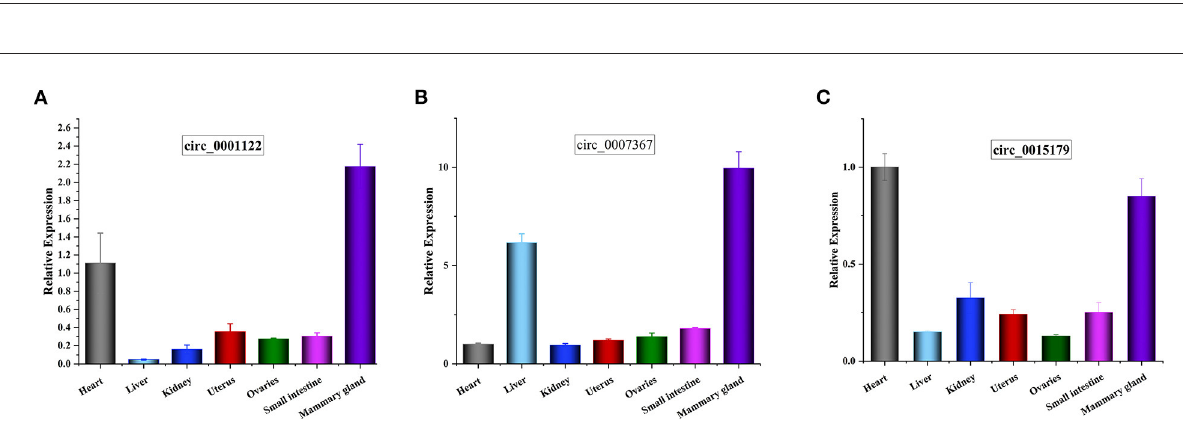
FIGURE7 (A–C) Tissue expression profiles for circ_0001122, circ_0007367, and circ_0015179, respectively, horizontal axis shows different tissues, vertical axis shows relative expression